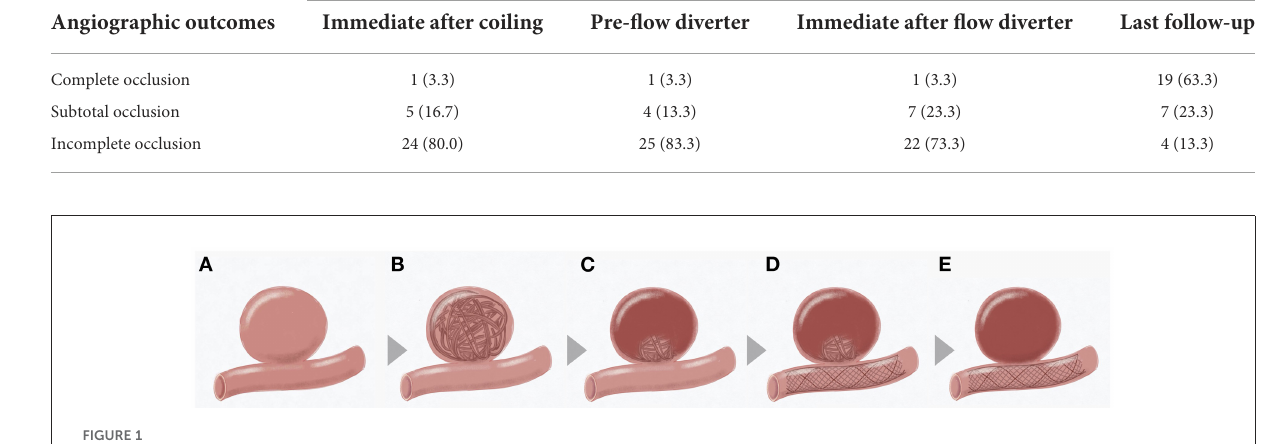
patient, subtotal occlusion in 5 (16.7%), and incomplete occlusion in 24 (80.0